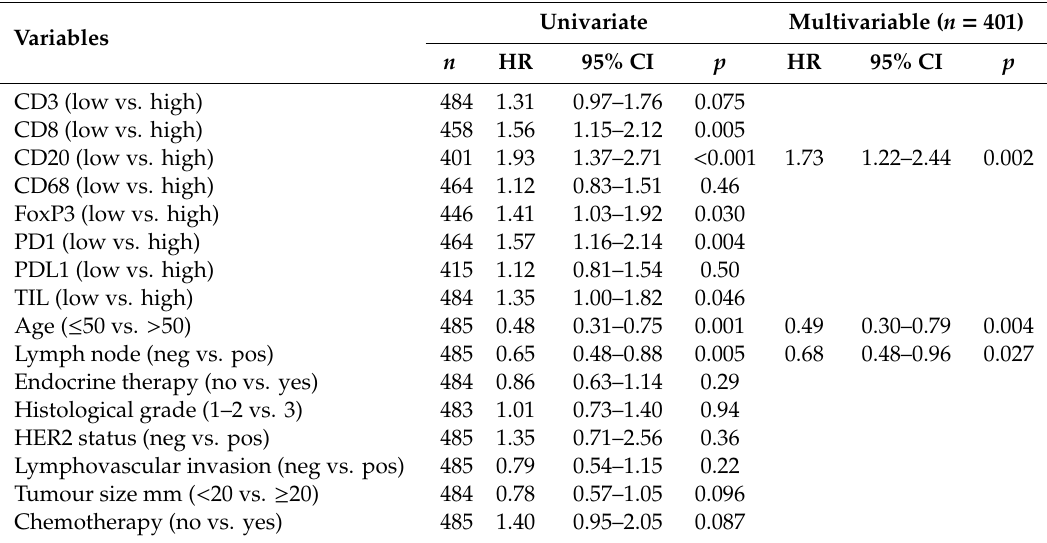
Table 2. Univariate and multivariate analyses for overall survival (OS) in the whole cohort. Univariate Multivariable ( n = Variables